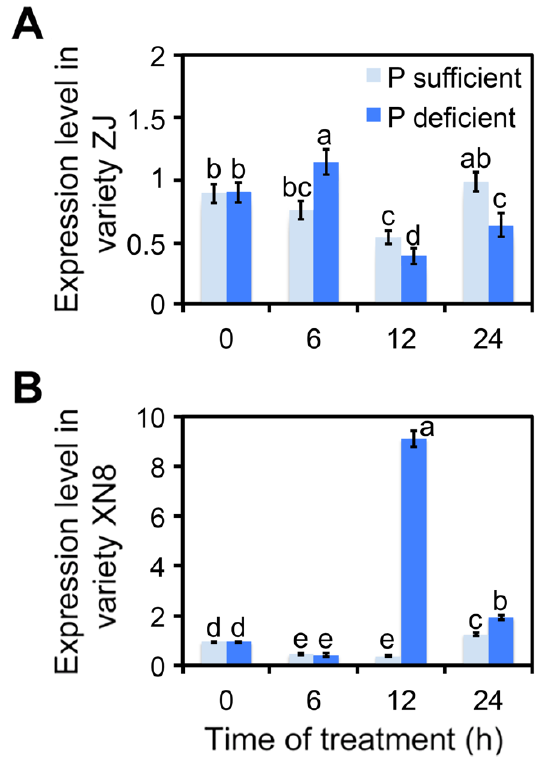
Figure 2. ClmiR86 expression varies in roots of watermelon genotypes with different P utilization efficiencies. Expression of ClmiR86 in the roots of ( A ) inefficient P utilization watermelon genotype “ZJ” and ( B ) efficient P utilization genotype “XN8” under different P concentrations. Different lower-case letters denote a significant difference in relative expression level ( p < 0.05, one-way ANOVA and then Tukey’s test for multiple comparisons). Values are means ± SD ( n = 3).